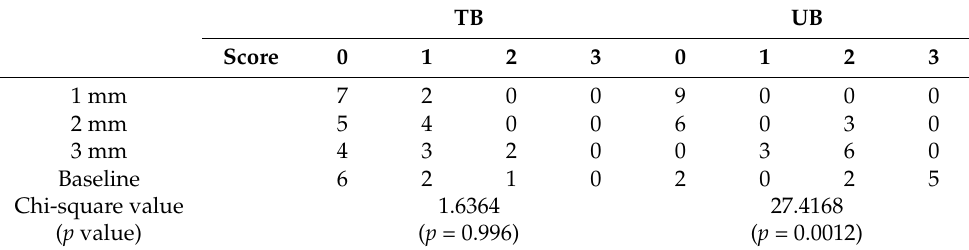
Table 2. ARI scores by pre-etched